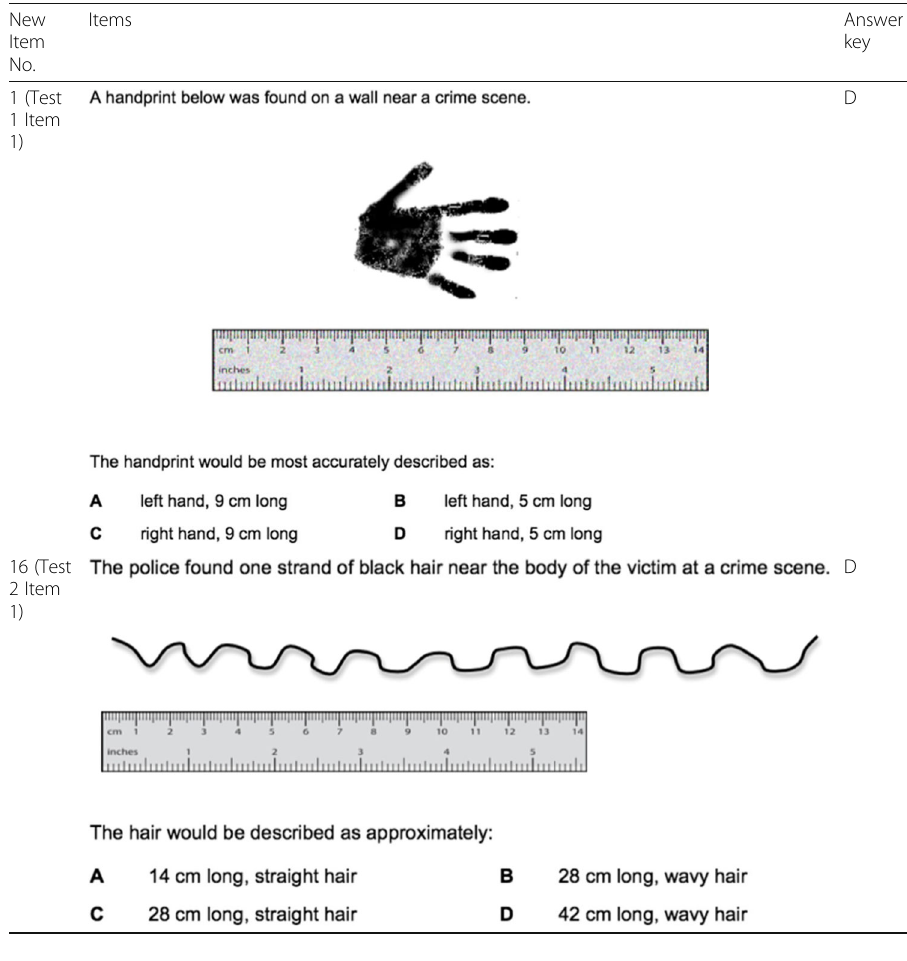
Table 1 Sample items designed with increased difficulty from Test 1 to Test 2 New